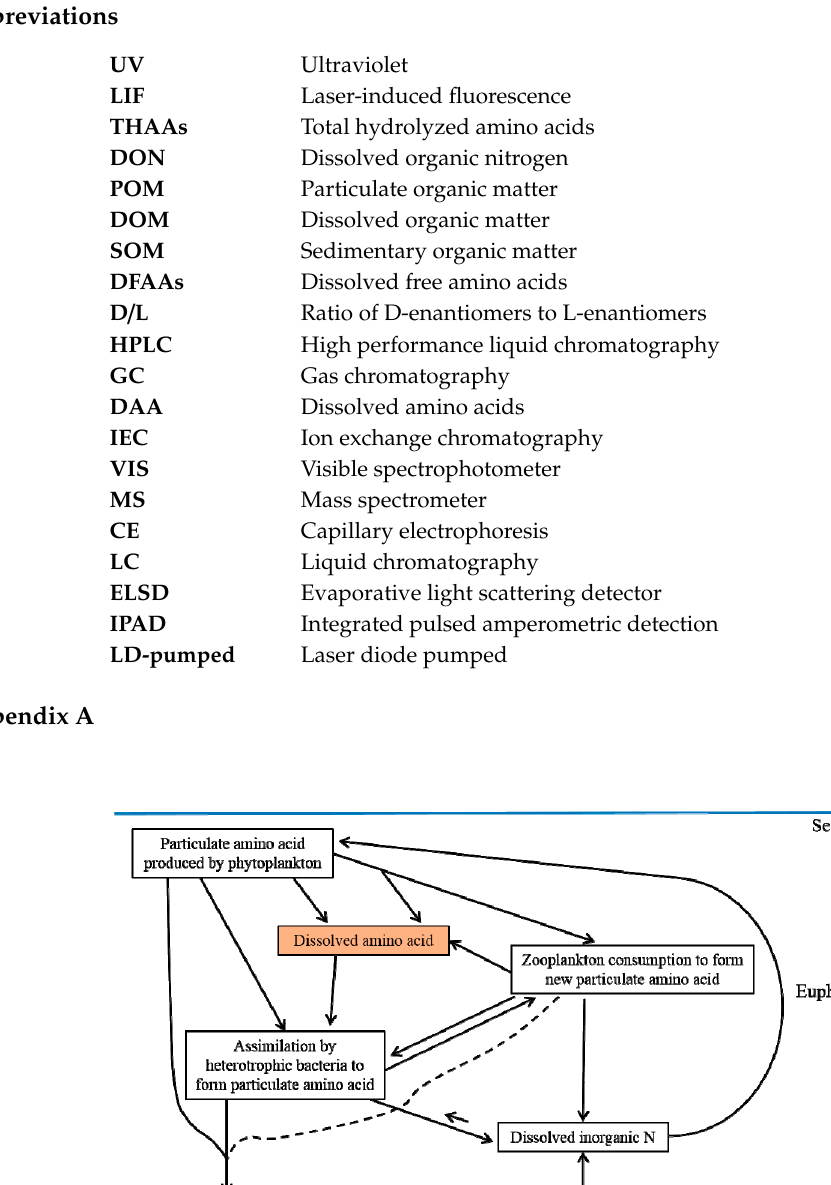
Table A1. Comparison of amino acid detection methods.